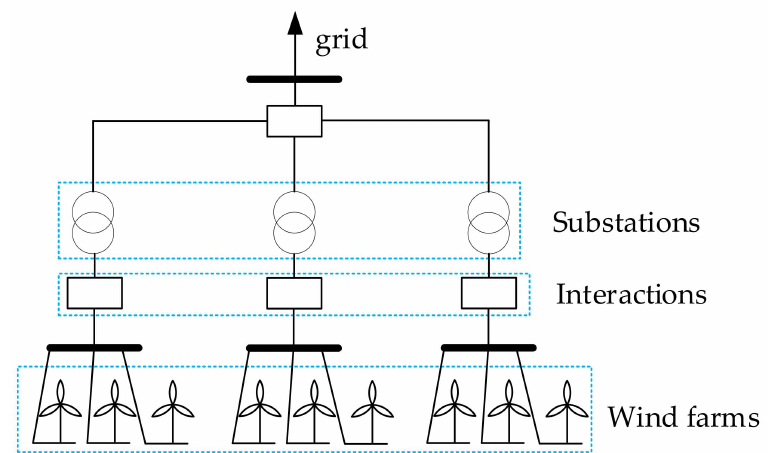
Figure 1. Distributed model of WFC